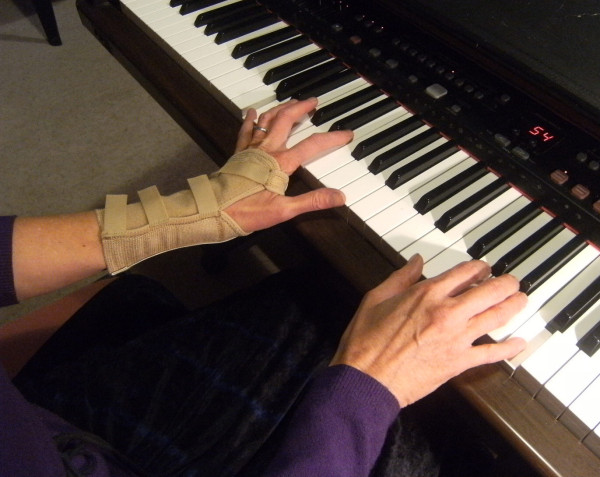
Futuro© wrist splint.